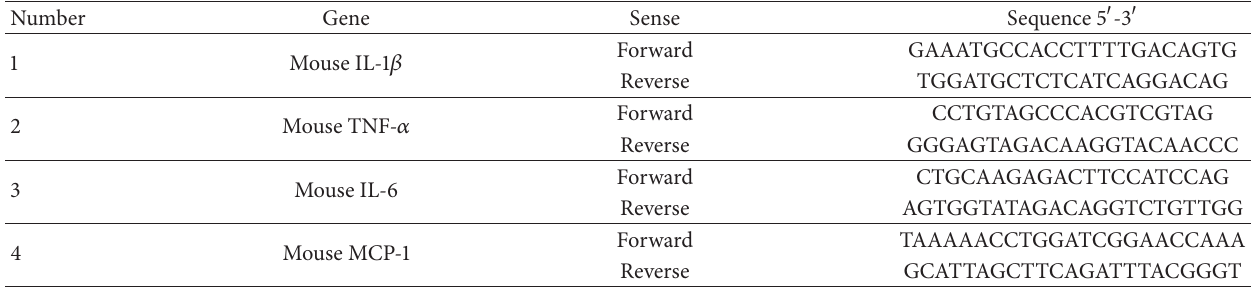
Table 2: The sequence of primers used for real-time PCR experiments to detect the mRNA levels of specified genes in mice organ